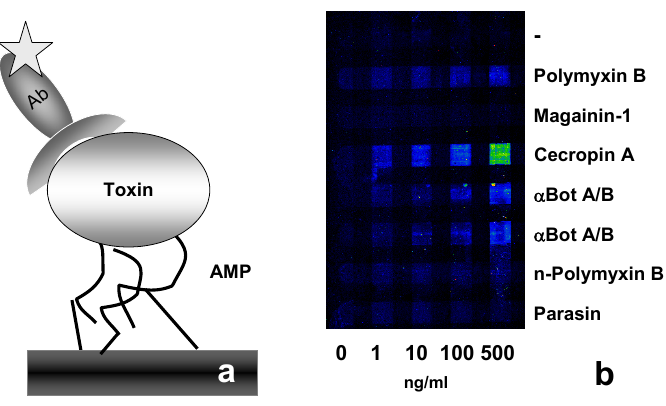
Figure 1 . Sandwich assays for botulinum toxoids using immobilized AMPs. Panel a: Schematic of sandwich-format assay for inactivated botulinum toxins. Anti-botulinum toxin antibody (Ab) is shown labeled with a fluorophore ( (cid:144) ). Panel b: Representative image of AMP-capture sandwich format assay for inactivated botulinum neurotoxin A. Cecropin A demonstrates high affinity for the toxin with a detection limit below 1 ng/ml; the detection limit for control antibodies ( α Bot A/B) was 10 ng/ml. No significant binding was observed in the negative control lane (-) or in the buffer blanks. Fig. 1b shows a representative image of a patterned array of AMPs used to detect botulinum toxoid A in a 75-min "sandwich" format assay using a fluorescent antibody tracer to detect bound toxoid. Dose-response curves were generated for binding of toxoids A and B to the immobilized peptides (Fig. 2). Detection limits were then determined as the lowest concentrations tested with mean net signals (n ≥ 3 separate array elements) at least 3 standard deviations above the mean of negative controls (buffer blanks) and are shown in Table 2.